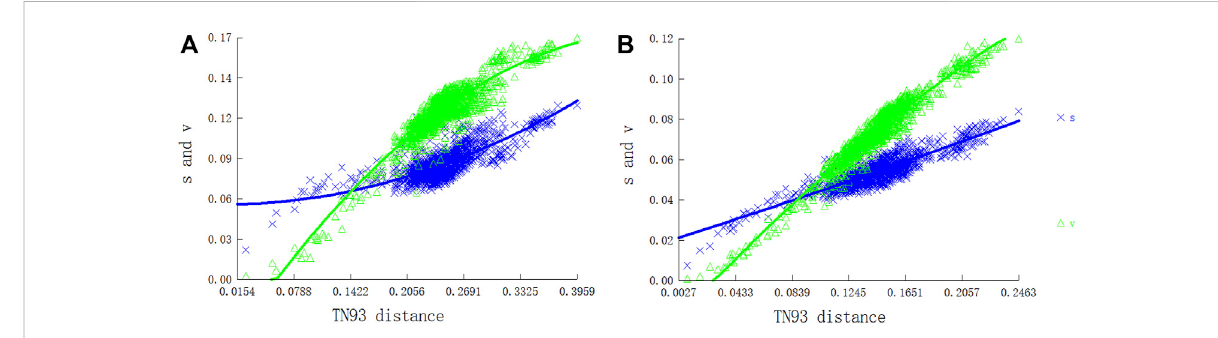
FIGURE 8 Nucleotide substitution saturation plots of all mitochondrial protein-coding genes: (A) All codon positions; (B) First and second codon